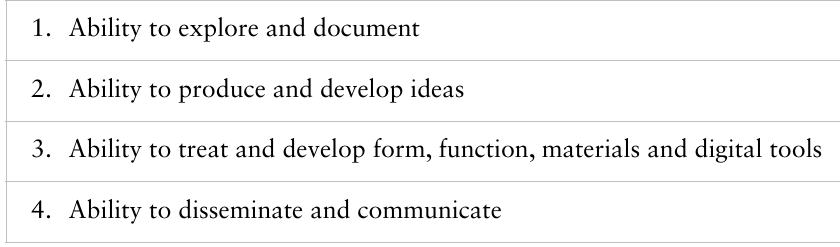
Table 1. The school’s four of fi cial assessment